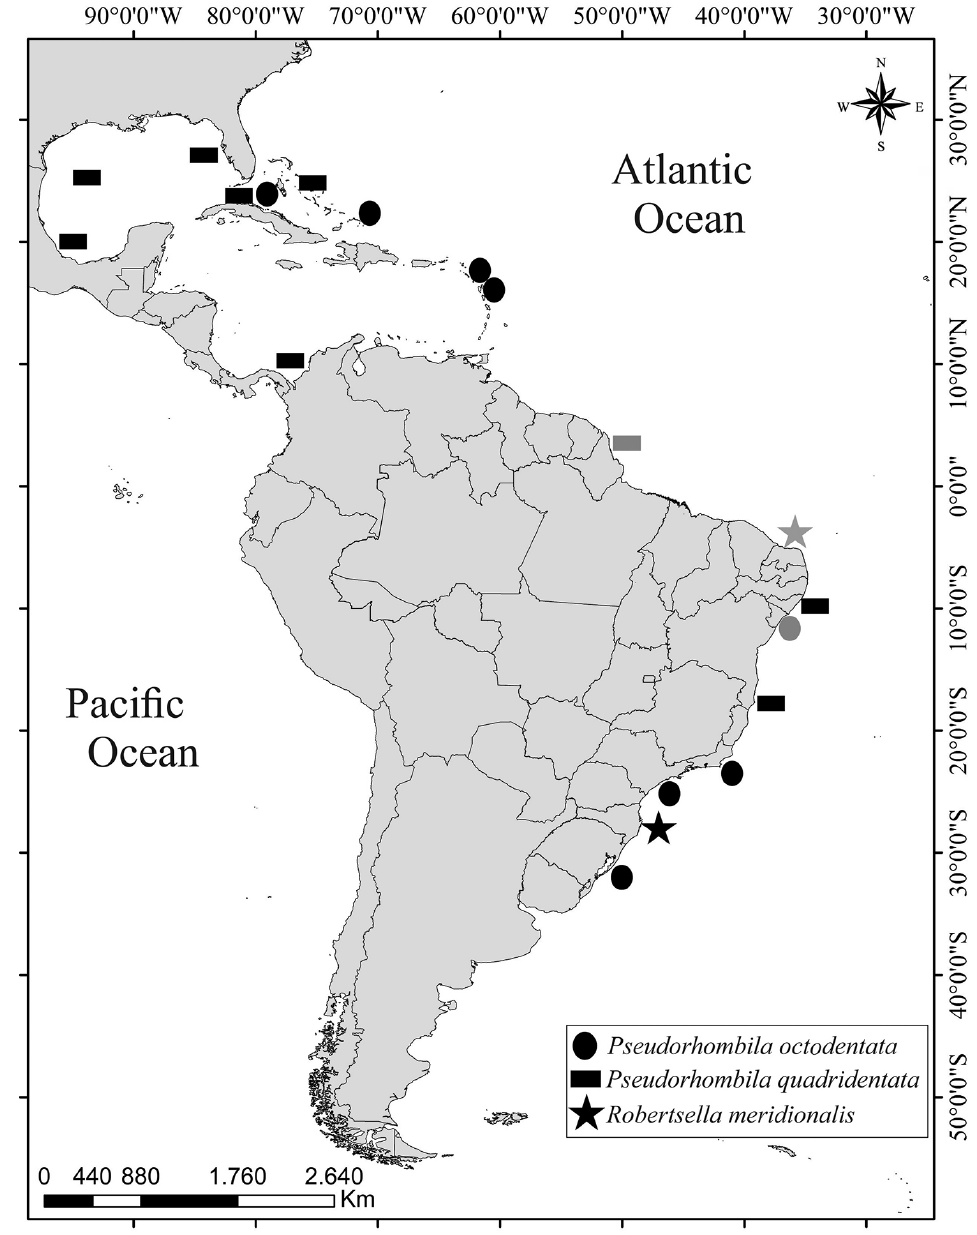
Figure 5. Geographic distribution of the Pseudorhombilidae from the Western Atlantic: Pseudorhombila octodentata Rathbun, 1906 (circle); P. quadridentata (Latreille, 1828) (square); Robertsella meridionalis Tavares and Gouvêa, 2013 (star). Black symbols = previous records; Gray symbols = new